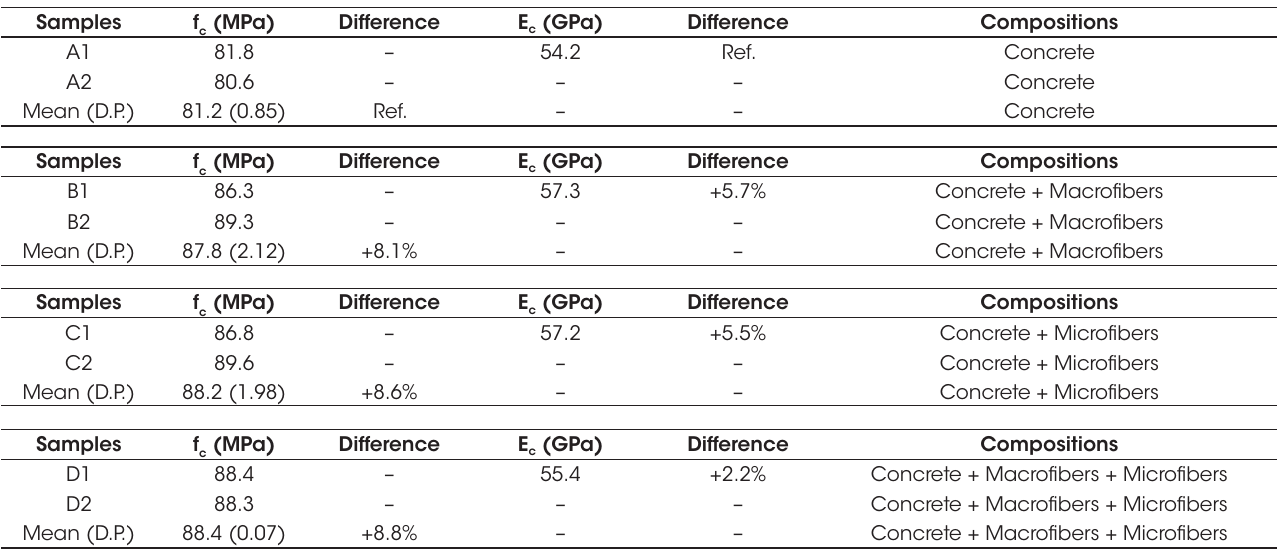
Table 3 Results of compressive strength and modulus of elasticity (20 × Ø10 cm) Samples